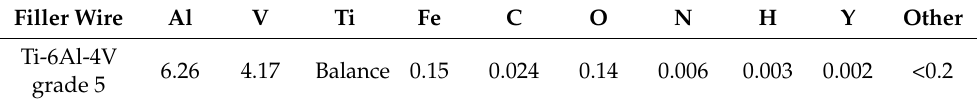
Table 2. Chemical composition given by the provider of Ti-6Al-4V grade 5 wire (wt.%). Filler